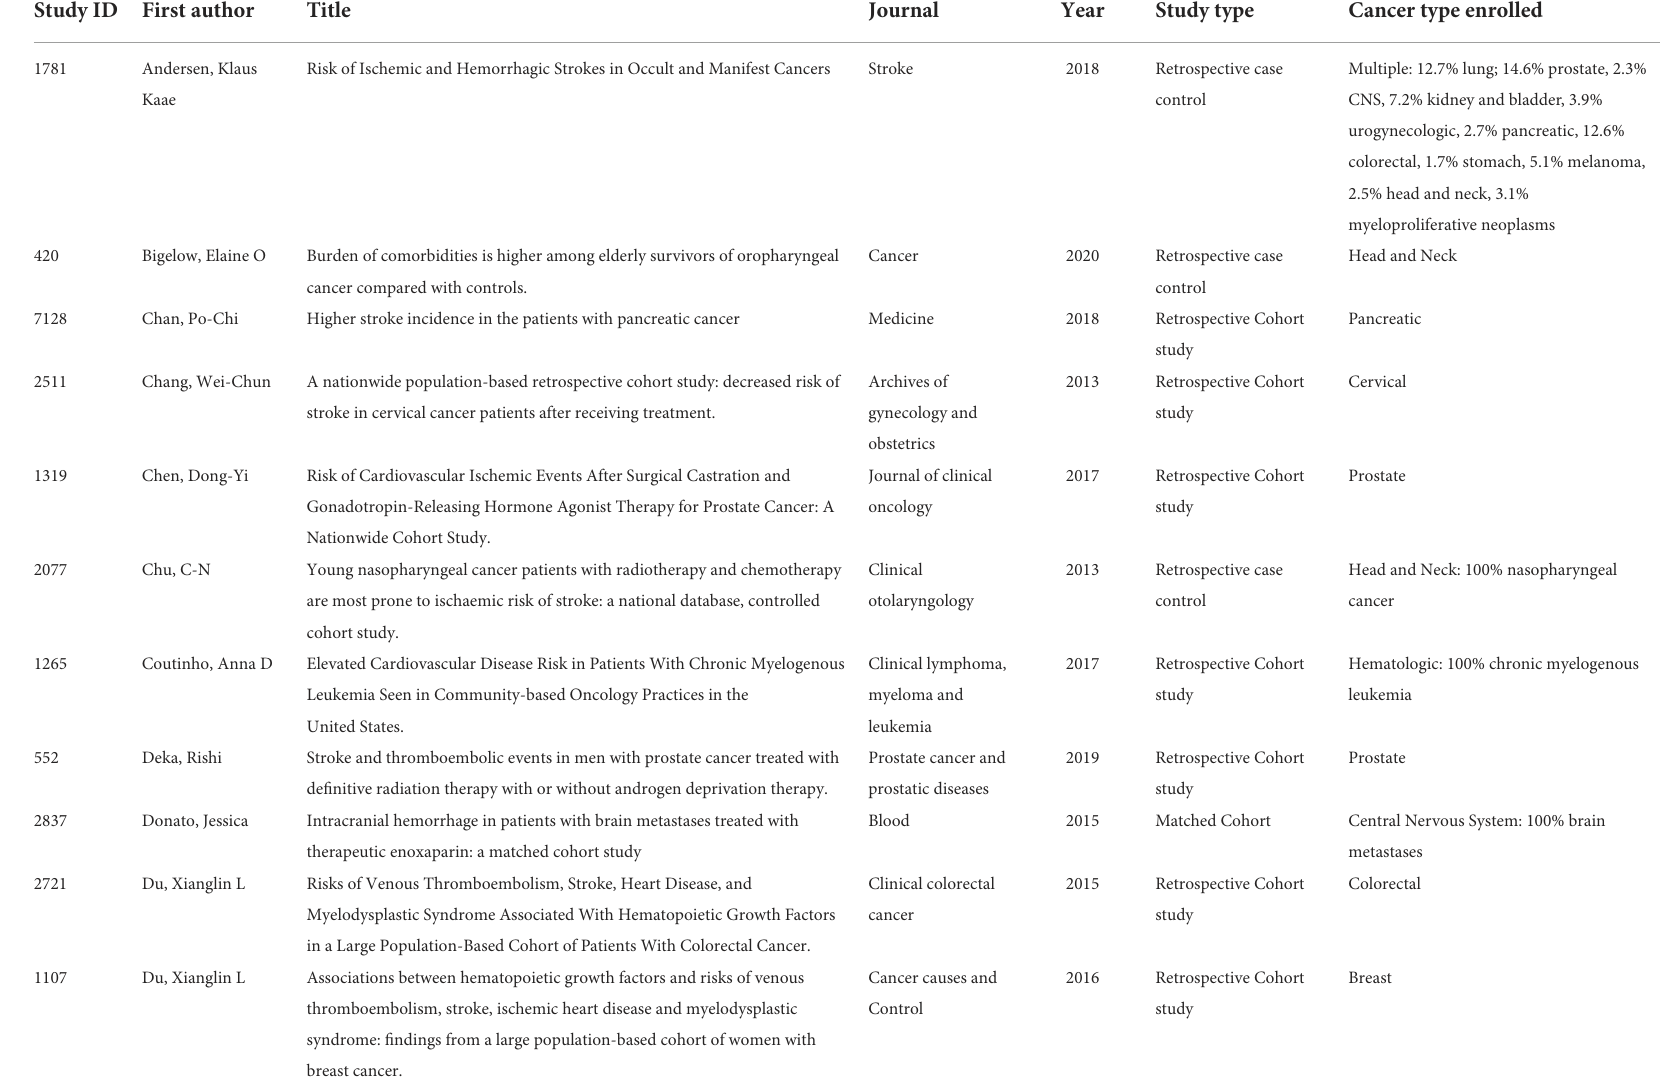
TABLE 1 Included full-text articles for data extraction and